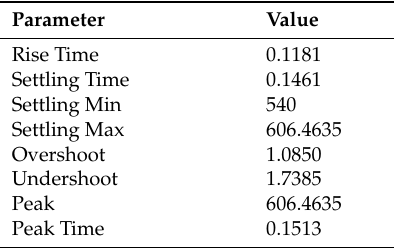
Table 2. Characteristics of the motor speed curve.